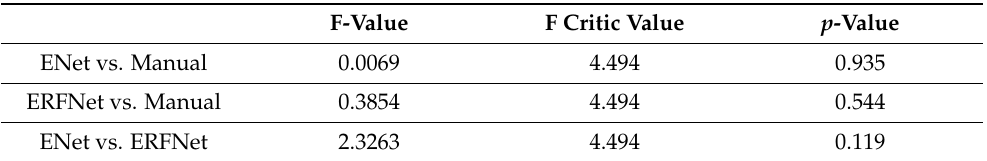
Table 2. Analysis of variance (ANOVA) on retroperitoneal sarcoma volumes showed no significant difference between manual and automatic